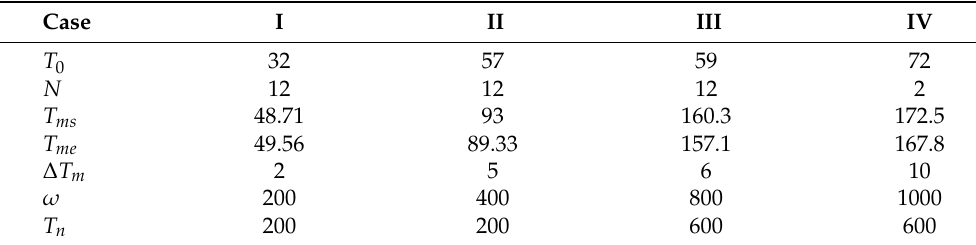
Figure 11. Temperature variation at different working conditions. Table 3. Experimental data and simulation results under different working